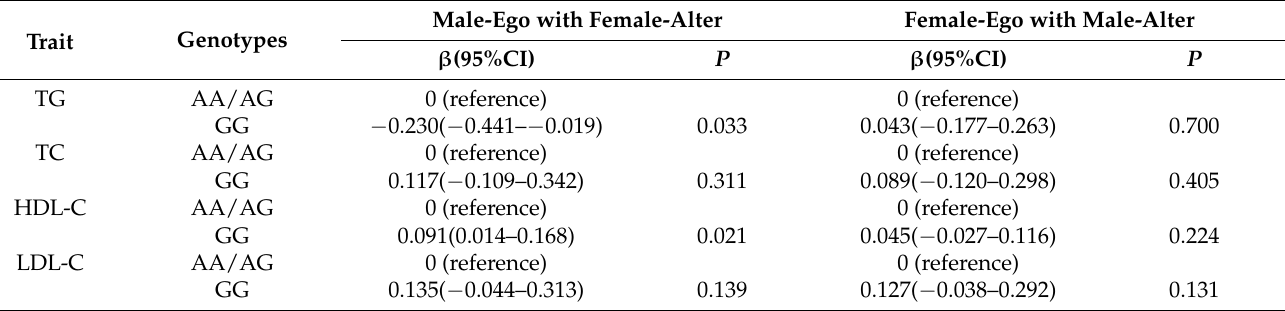
Table 5. Effects of the alter rs182052 genotypes on ego lipid levels stratified by specific